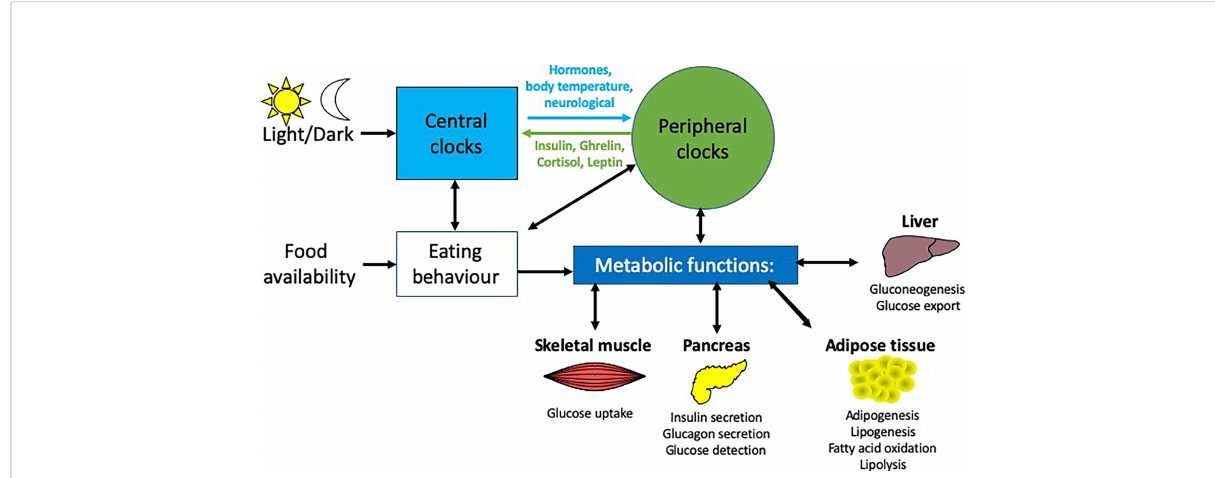
FIGURE 2 Circadian in fl uences on different metabolic tissues. Light is the main entrainment factor for the SCN, the master pacemaker of the circadian system, which, through a number of signals e,g. hormones and neurotransmitters, synchronizes the circadian rhythms of peripheral tissues to light exposure. Crosstalk between these peripheral tissues and the brain enable feedback to modulate these rhythms e.g.the hormones insulin, ghrelin, leptin and cortisol provide feedback to the arcuate nucleus in the brain. There are many peripheral tissues, which regulate metabolic functions, including the liver, pancreas, skeletal muscle and adipose tissue, each of which exhibit their own rhythmicity. Together, these peripheral rhythms regulate many metabolic functions, including glucose homeostasis, insulin secretion and fatty acid